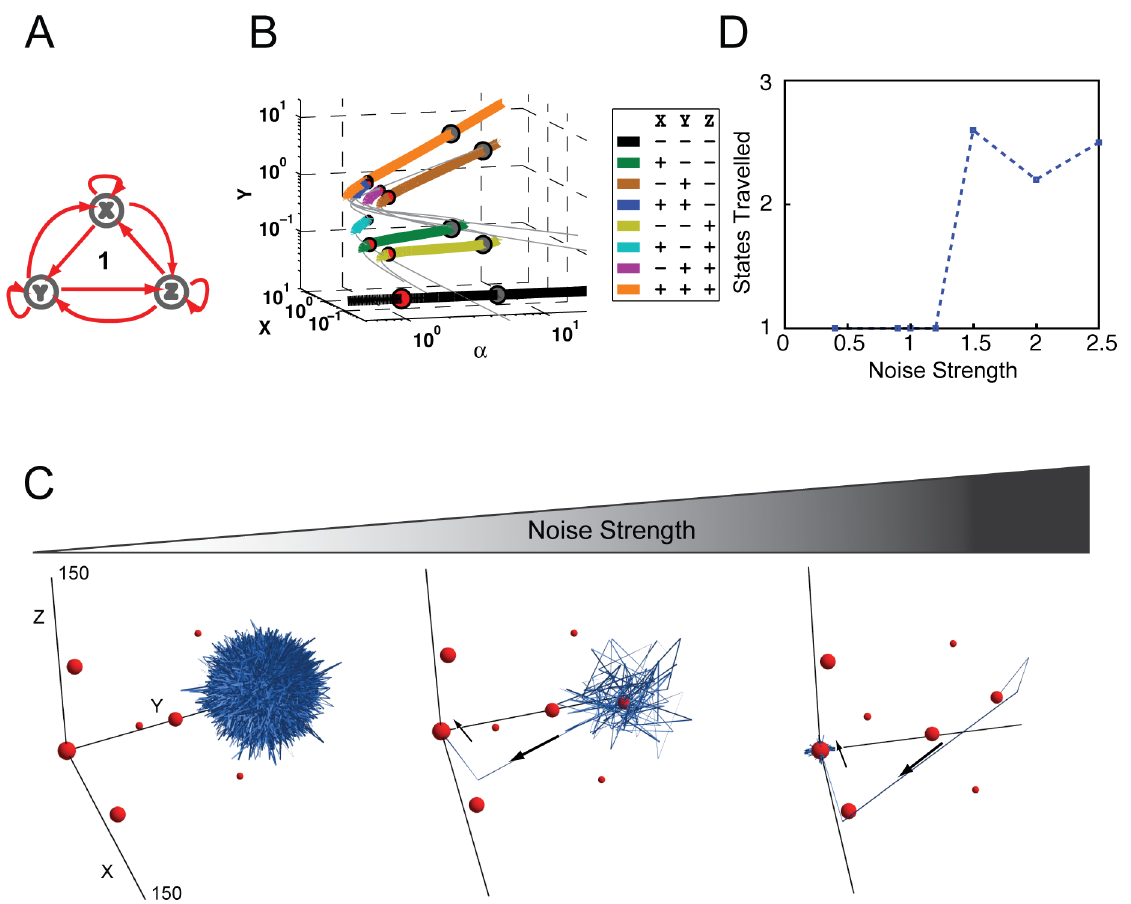
Figure 5. Bifurcation and Stochastic Analysis of Network 1. (A) The topology of Network 1 was also predicted to have high probability for multistability. Network 1 shares the topological architecture of the Oct4-Sox2-Nanog triad, and is believed to underlie stem cell differentiation and reprogramming. (B) As in Figure 3B, the X and Y protein concentrations of stable (colored) and unstable (gray) steady states at various self-activation strengths can be seen. A legend is shown as in Figure 3. (C) Simulations of noise-induced state transitioning in Network 1 under different levels of noise. Simulations were performed with auto-regulation equal to 1 and mutual regulation equal to 0.1, with noise levels of 0.5, 0.85, and 1 from left to right. The locations of the deterministically calculated states are indicated with red spheres, with their size being correlated to their spectral radius. The blue ribbons indicate the temporal trajectories of the simulations. The black arrows indicate initial direction of state transitions. Potential cloud shape for each SSS is illustrated in Figure S6B. (D) The number of states traveled in the stochastic simulations plotted versus noise